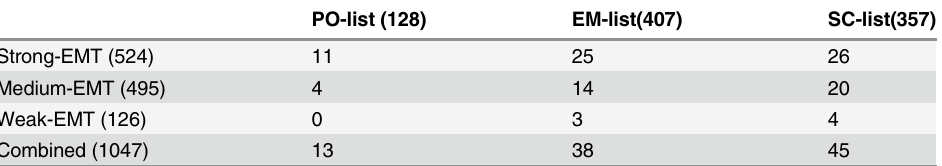
Table 2. Removing weakly-induced samples does not improve